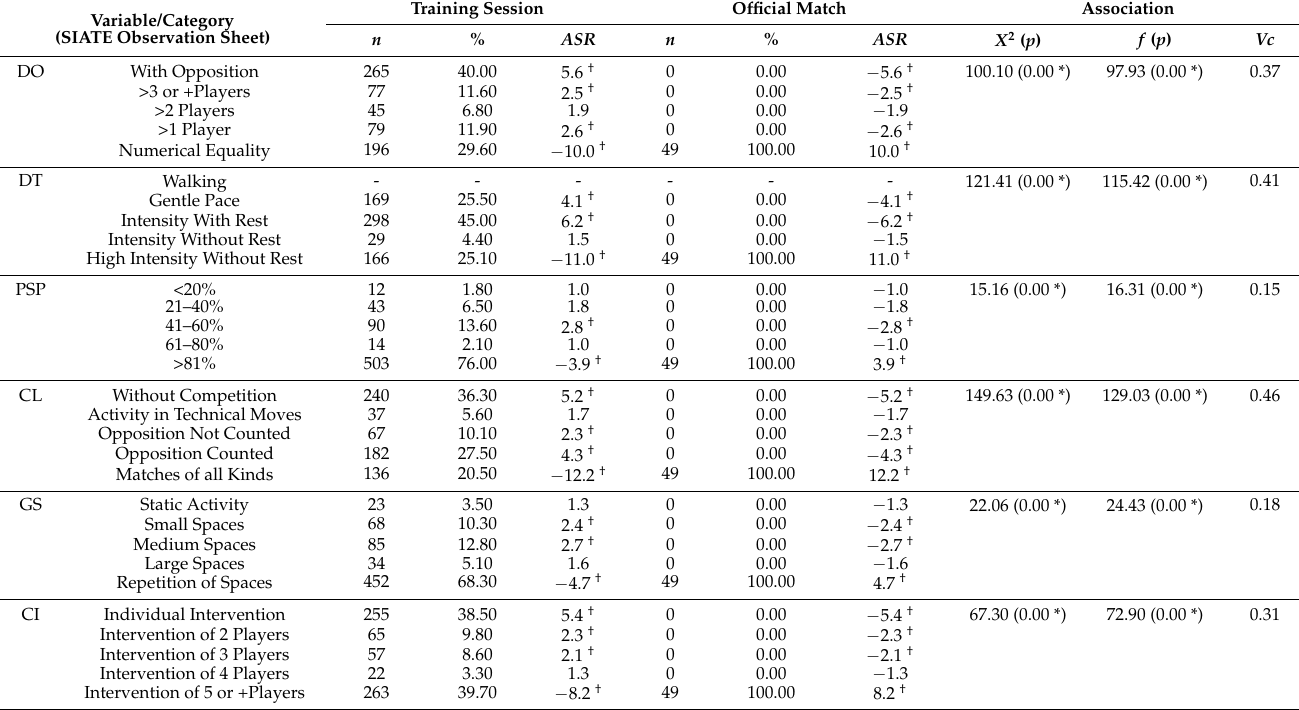
Table 4. Percentages, ASR and association of the subjective eTL variables.